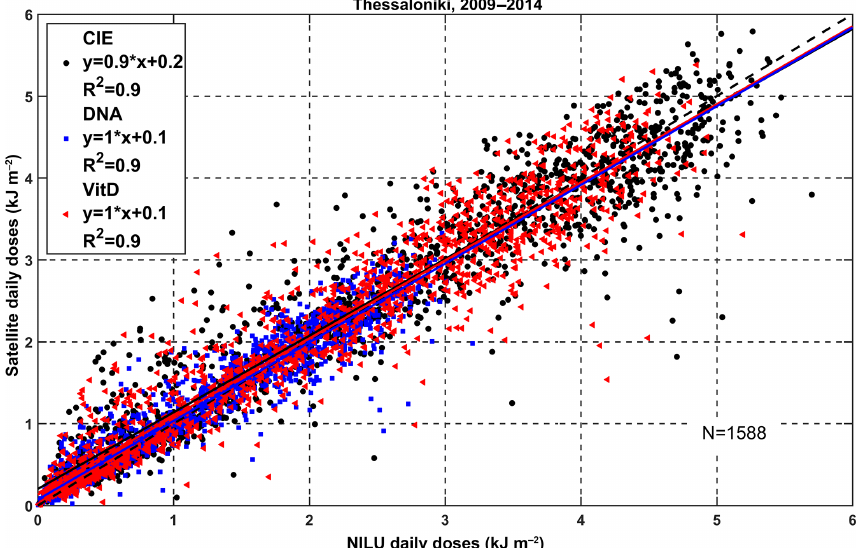
Figure 7. Scatter plot of daily UV dose values provided by the joint SCIA / GOME2A UV products ( y axis) and NILU103 ( x axis) in kJm − 2 under all-sky conditions.